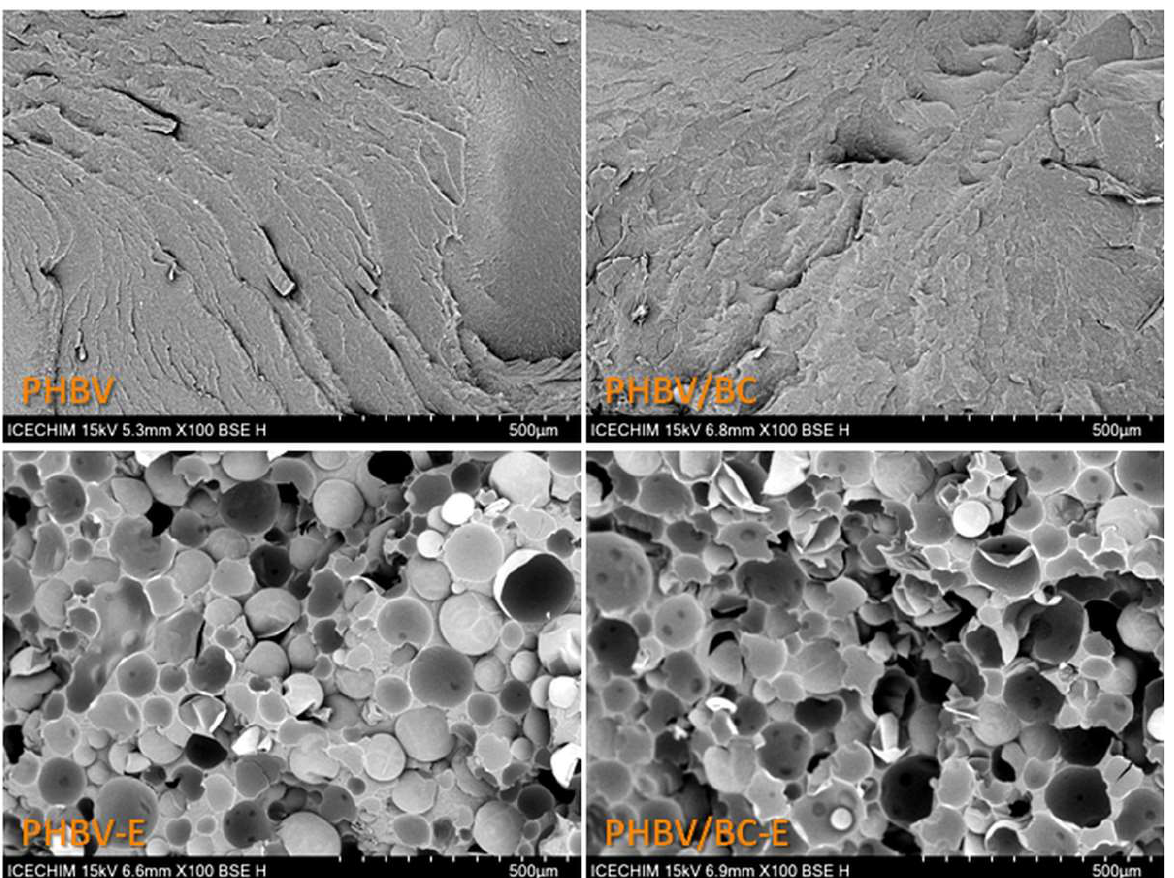
Figure 1. SEM images of PHBV, PHBV/BC, and corresponding foamed